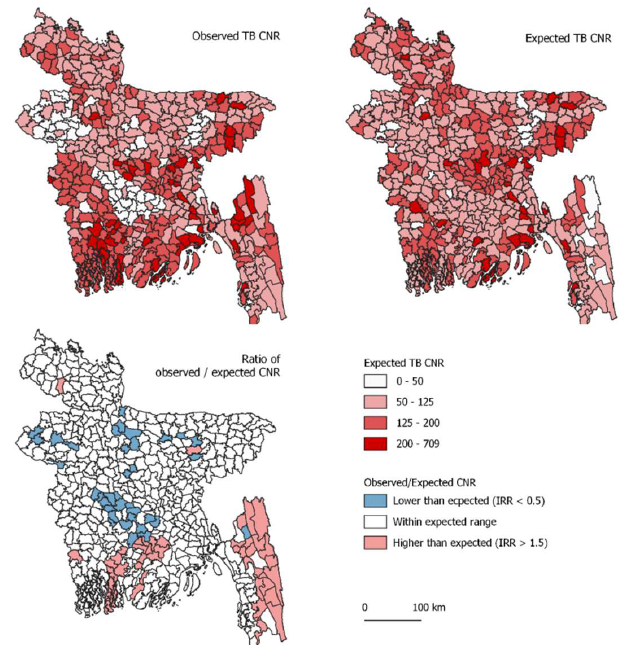
Figure 4. Maps of observed and predicted case notification rates across 484 upazilas in Bangladesh in 2016. Predicted case notification rates (CNRs) were created by accounting for differences in poverty, testing rates, retreatment rates and spatial correlations between each upazila and its 10 nearest neighboring upazilas. Incidence Rate Ratios (IRR) were calculated by dividing the observed CNR by the predicted CNR.